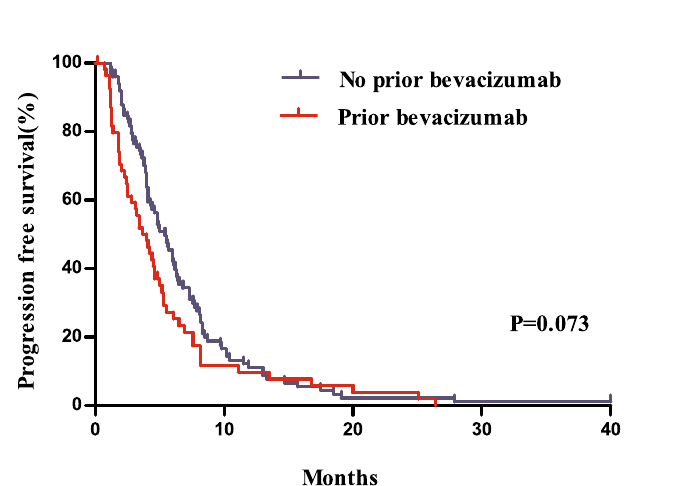
Figure 5. Comparison of progression free survivals between patients with and without a history of bevacizumab treatment.